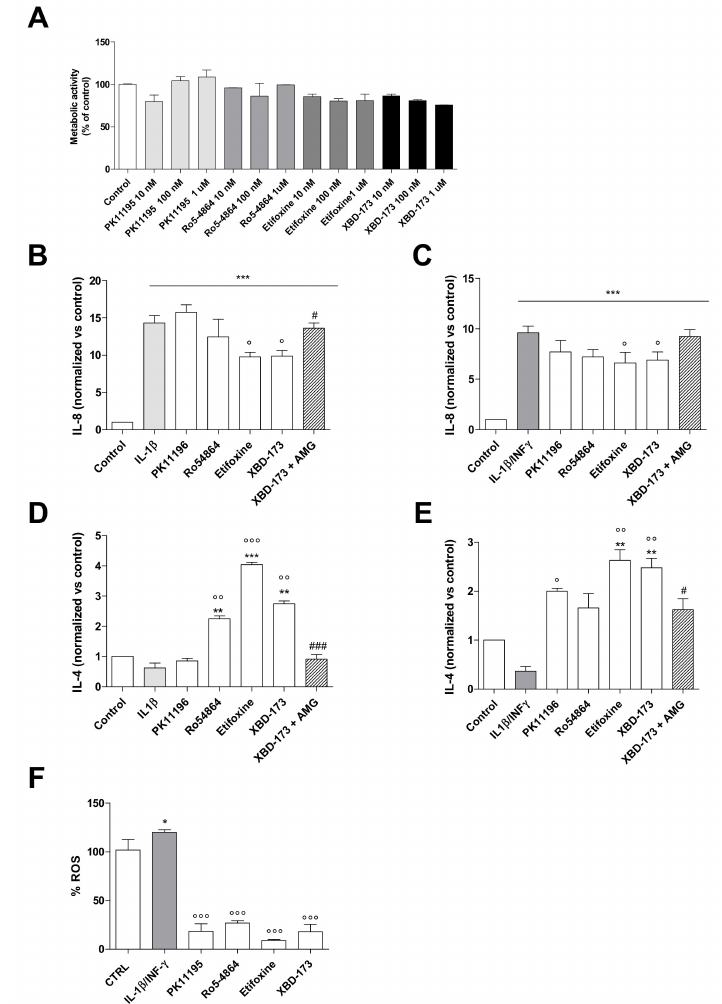
Figure 4. E ff ects of TSPO pharmacological stimulation on cell viability of C20 cells and interleukin release from inflamed C20 cells. ( A ) TSPO ligands’ e ff ects on C20 cell viability. Cells were treated with three di ff erent concentrations of PK11195, Ro5-4864, XBD-173, or Etifoxine (10 nM, 100 nM, and 1 µ M) in serum-free medium. The MTS assay was performed after 24 h of treatment. Data are expressed as percentages of cell viability compared to the control, which was set to 100%. No significant di ff erences were observed. ( B – D ) C20 cells were pre-treated with TSPO ligands (100 nM) for 2 h in serum-free medium. Then, IL-1 β (20 ng / mL) or IL1- β / INF- γ (100 ng / mL / 50 ng / mL) was added. In the case of treatment with XBD-173, samples of the C20 cells were in parallel pre-treated with AMG (50 µ M) 1 h before the addition of the TSPO ligand. After 24 h, the IL-8 and IL-4 release was evaluated. In particular, the figure shows the release of IL-8 in the IL-1 β -inflamed sample ( B ), IL-8 in the IL-1 β / INF- γ -inflamed sample ( C ), IL-4 in the IL-1 β -inflamed sample ( D ), and IL-4 in the IL-1 β / INF- γ -inflamed sample ( E ). The concentration of interleukins was obtained by the enzyme-linked immunosorbent assay (ELISA) and normalized to the amount of cytokine in untreated cells set to 1. The bars represent the mean ± SEM of at least three duplicates from three di ff erent experiments. ( F ) C20 cells were treated as above and ROS generation was evaluated. Data are expressed as percentages with respect to control, which was set to 100%. Each bar represents the mean ± SEM of three replicates from two independent experiments. The significance of the di ff erences was determined by one-way ANOVA, which was followed by Bonferroni’s post-test or student t -test: * p ≤ 0.05, ** p ≤ 0.01, *** p ≤ 0.001, vs. control, ◦ p ≤ 0.05, ◦◦ p ≤ 0.01, ◦◦◦ p ≤ 0.001, vs. IL-1 β or IL1- β / INF- γ , # p ≤ 0.05, and ### p ≤ 0.001 vs.